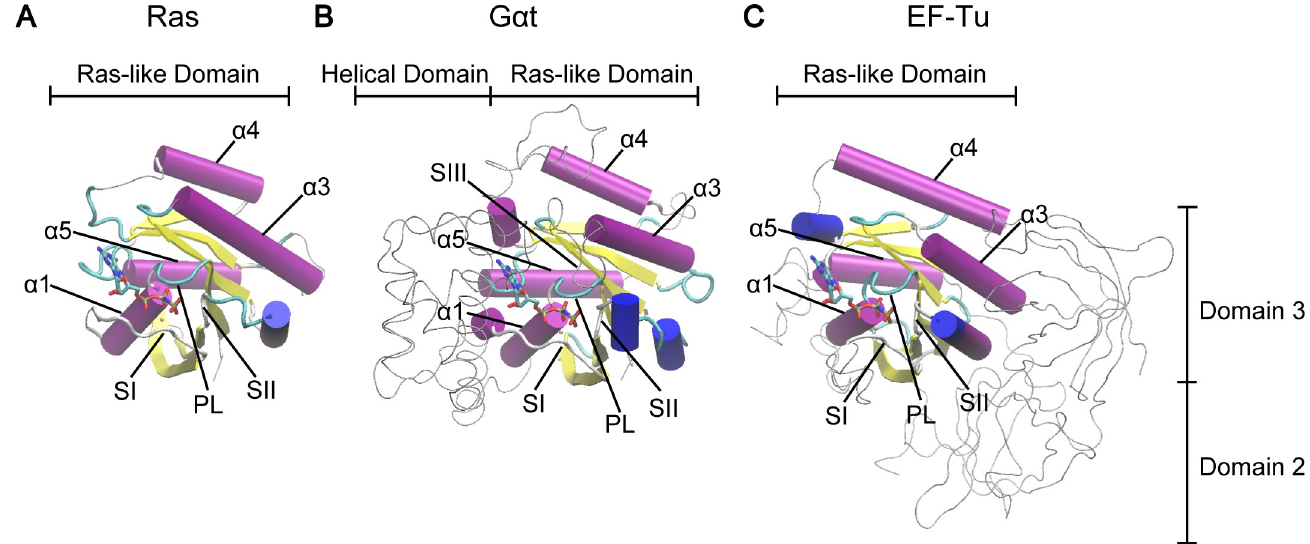
Fig 1. Structural comparison of Ras, G α t and EF-Tu reveals common canonical Ras-like domain. The Ras-like domains of Ras ( A ), G α t ( B ) and EF-Tu ( C ) are shown in cartoon and the extra domains in G α t and EF-Tu are shown as gray tubes. Highly conserved regions (PL, SI, and SII) and helices ( α 1, α 3, α 4, and α 5) are labeled. The PDB IDs of these three structures are 5P21 (Ras), 1TND (G α t) and 1TTT (EF-Tu).